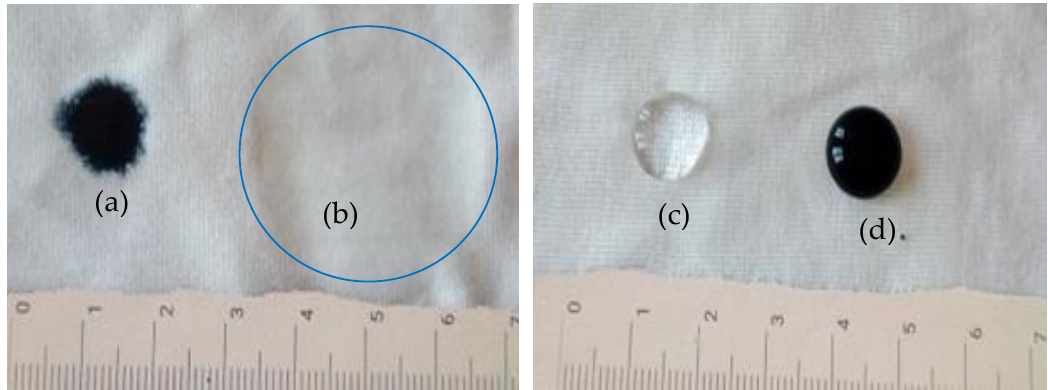
Figure 2. Effect of WR treatment on knitted cotton fabric: ( a ) PEDOT:PSS polymer dispersion on untreated fabric (S0); ( b ) drops of water on untreated fabric (S0); ( c ) drops of water on water repellent (WR)-treated fabric (S1); ( d ) PEDOT:PSS polymer dispersion on water repellent (WR)-treated fabric.